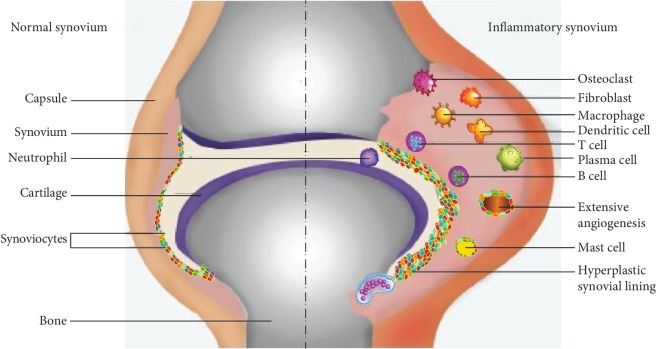
Schematic view of (a) normal joint and (b) RA joint.